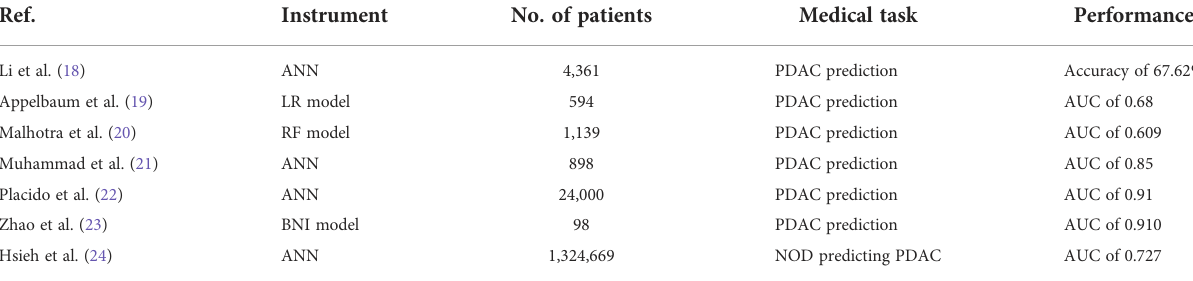
TABLE 3 Predicting pancreatic cancer through risk